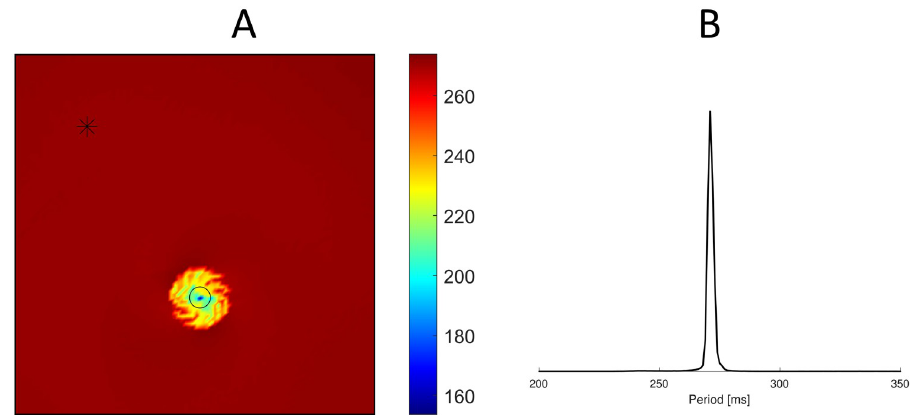
Fig 8. Mean period map and period spectra during reentry dynamics. (A) Mean period map computed over 2 s of simulation after 2 s the S2 stimulus. The black markers indicates the two point where membrane potentials of Fig 7 were evaluated. (B) Period spectra over 2 s of simulation after 2 s the S2